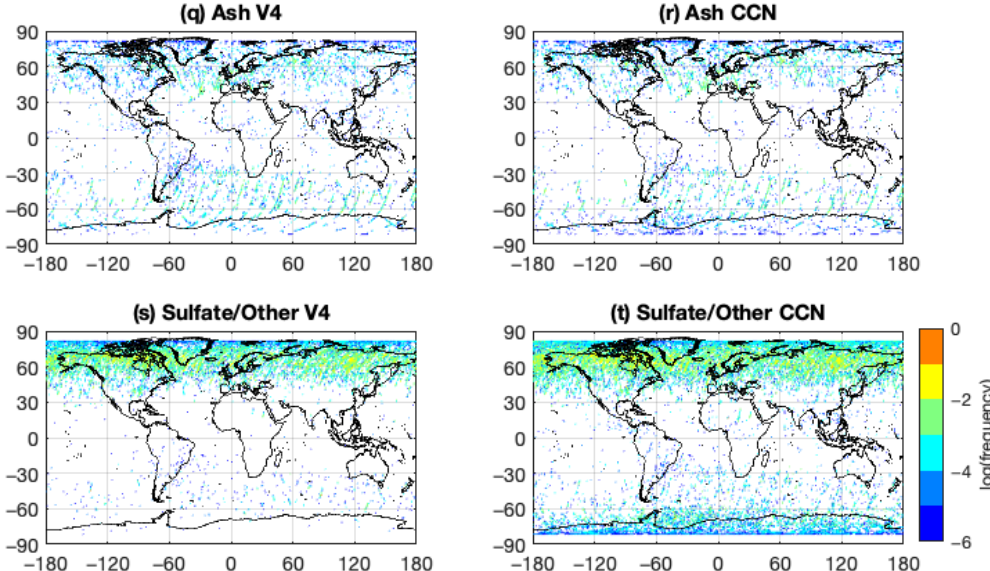
Figure 9. Geographical distributions of aerosol subtypes identified by the V4 COSCAs ( a ): marine aerosols; ( c ): dust; ( e ): dusty marine; ( g ): polluted dust; ( i ): polluted continent or smoke ( k ): elevated smoke; ( m ): clean continental aerosols; ( o ): PSC aerosols; ( q ): Ash; ( s ): sulfate or other stratospheric aerosols) and the CNN ( b ): marine aerosols; ( d ): dust; ( f ): dusty marine; ( h ): polluted dust; ( j ): polluted continent or smoke ( l ): elevated smoke; ( n ): clean continental aerosols; ( p ): PSC aerosols; ( r ): Ash; ( t ): sulfate or other stratospheric aerosols) for the same data used in Table 1.